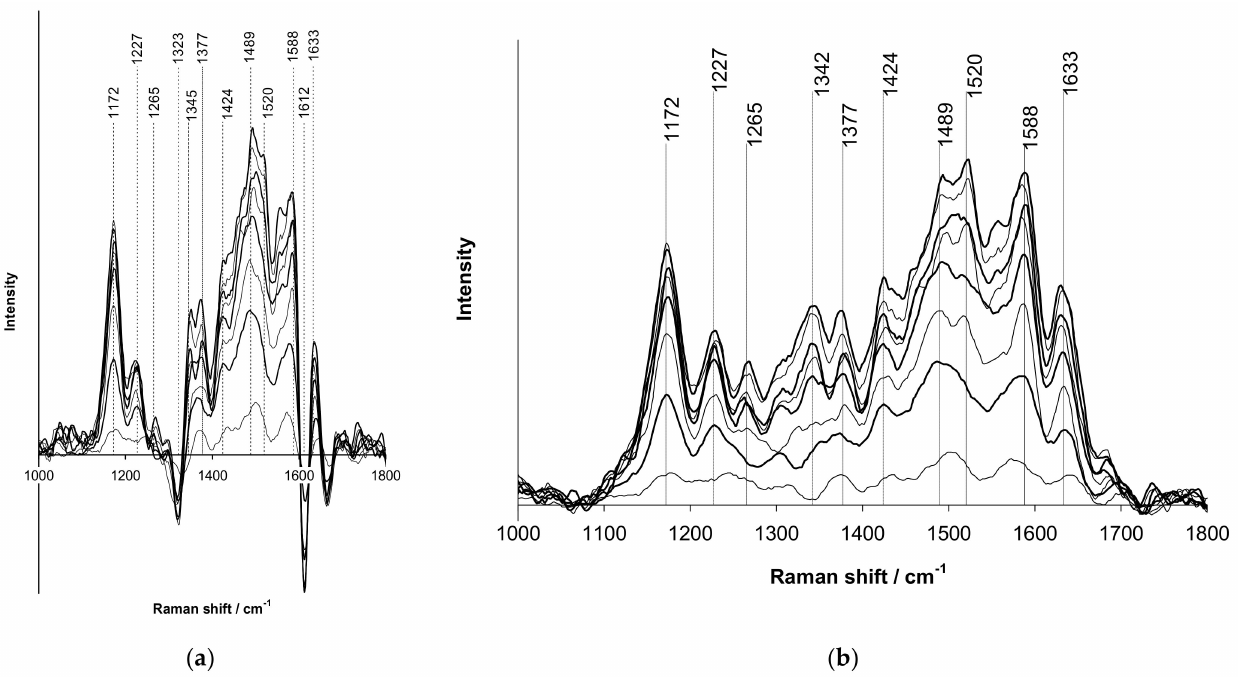
Figure 7. Evolution of the Raman spectra of PANI film during galvanostatic polymerization of aniline in the presence of t-PASA: ( a ) uncorrected, baseline subtracted; ( b ) corrected, baseline subtracted. Reprinted from Journal of Electroanalytical Chemistry Volume 873, A.A. Nekrasov et al., “Raman spectroelectrochemical monitoring of conducting polymer electrosynthesis on reflective metallic electrode: Effects due to double excitation of the electrode/film/solution interfaces”, Pages No. 114415(1-12), Copyright 2020, with permission from Elsevier